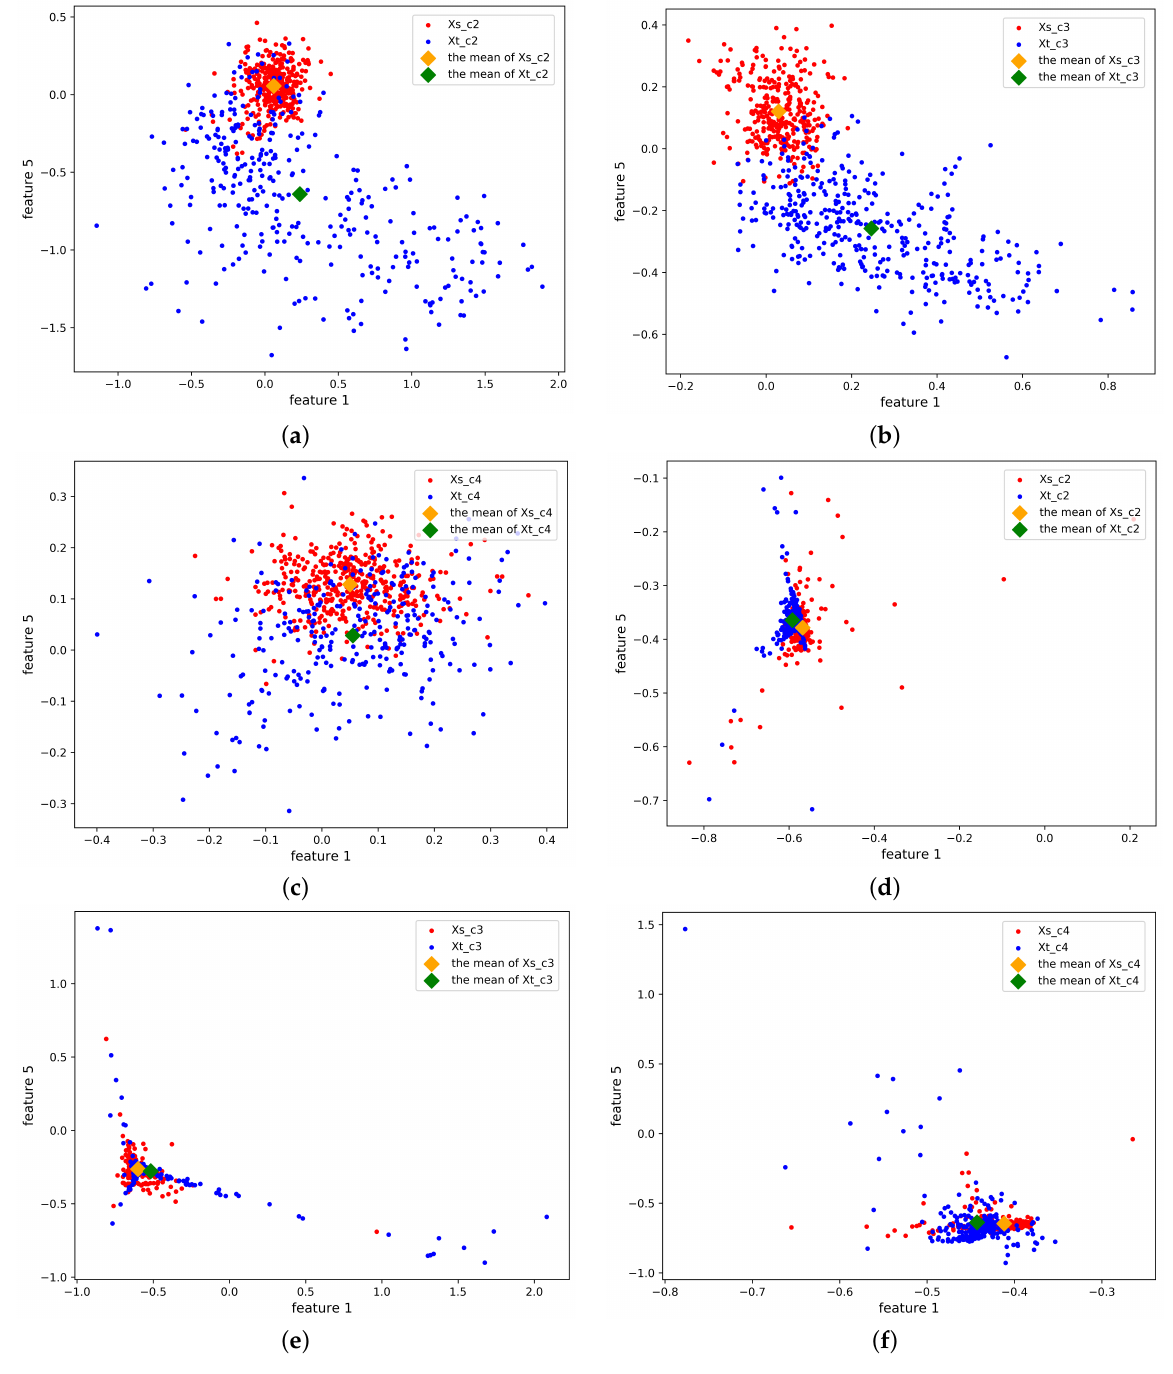
Figure 4. Class alignment on BOT5–6. ( a ) BLS on class 2 ( b ) BLS on class 3 ( c ) BLS on class 4